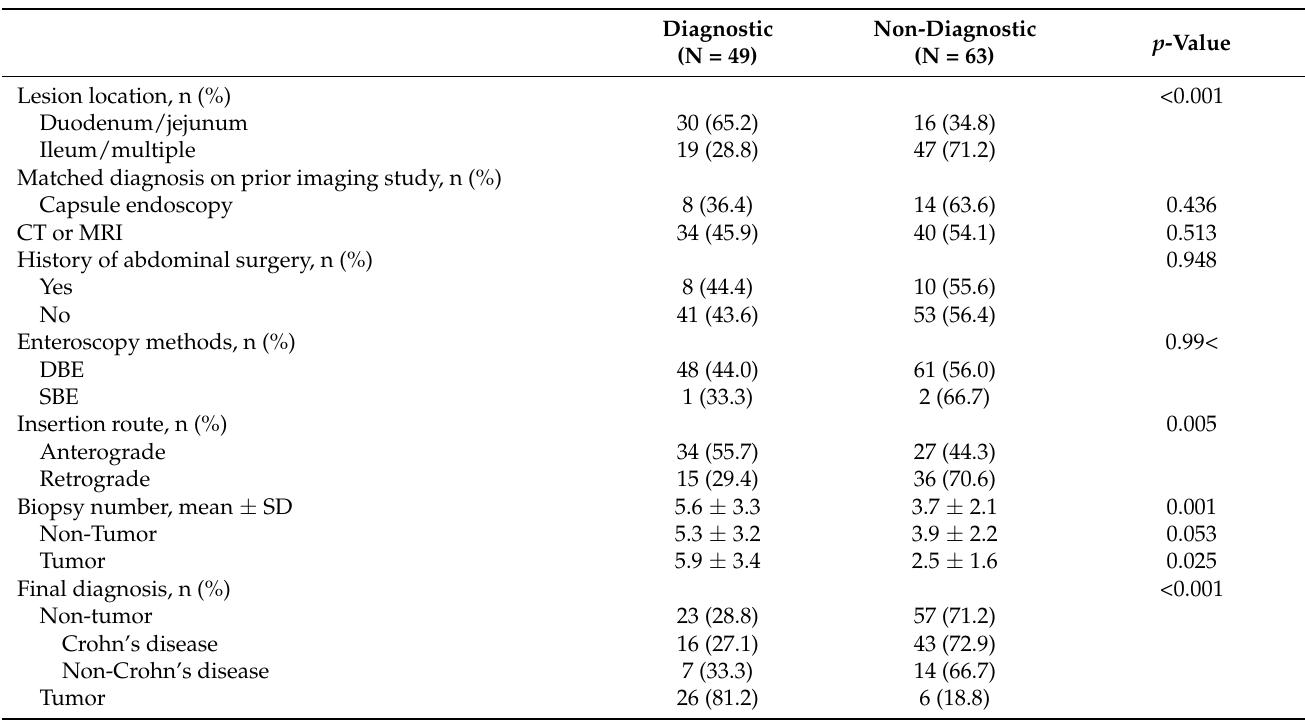
Table 3. Diagnostic yields of enteroscopic biopsy according to the technical characteristics of device assisted enteroscopy and final diagnosis.